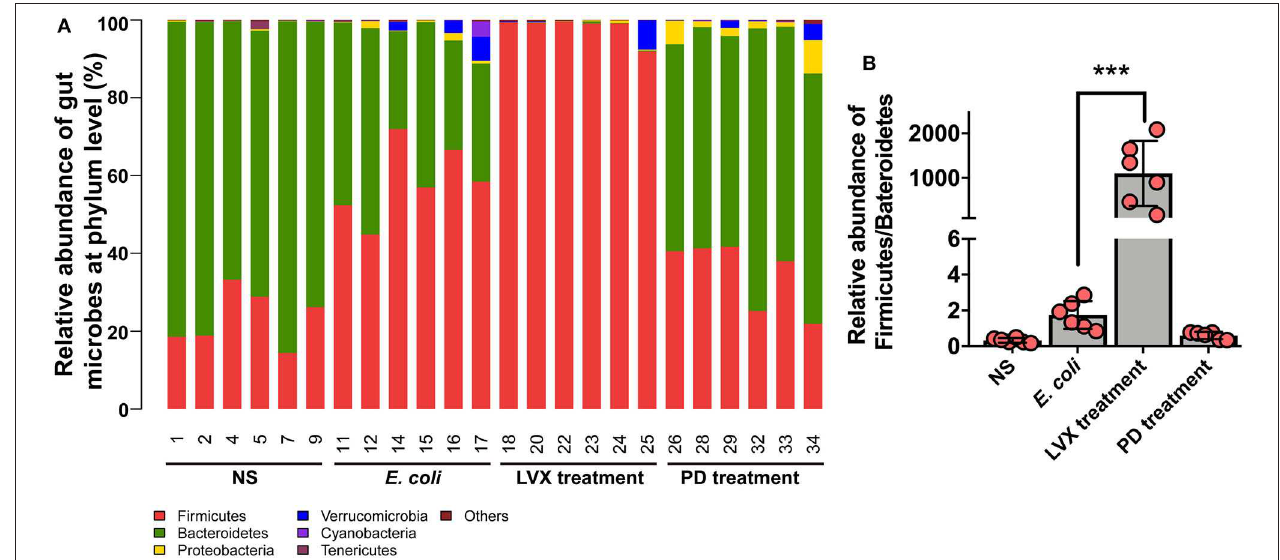
FIGURE 5 | Microbial composition of PD or LVX treatment at the phylum level. (A) Distribution of bacterial taxa under PD or LVX treatment at the phylum level. Sequences that could not be classified into any known group were designated as “unclassified”. (B) Relative abundance of Firmicutes/Bacteroidetes under PD or LVX treatment. Date showed the mean ± SD (*** P < 0.001, n =